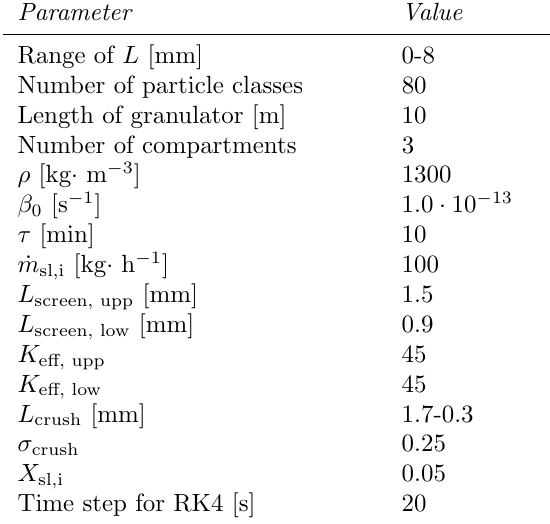
Table 1: Simulation